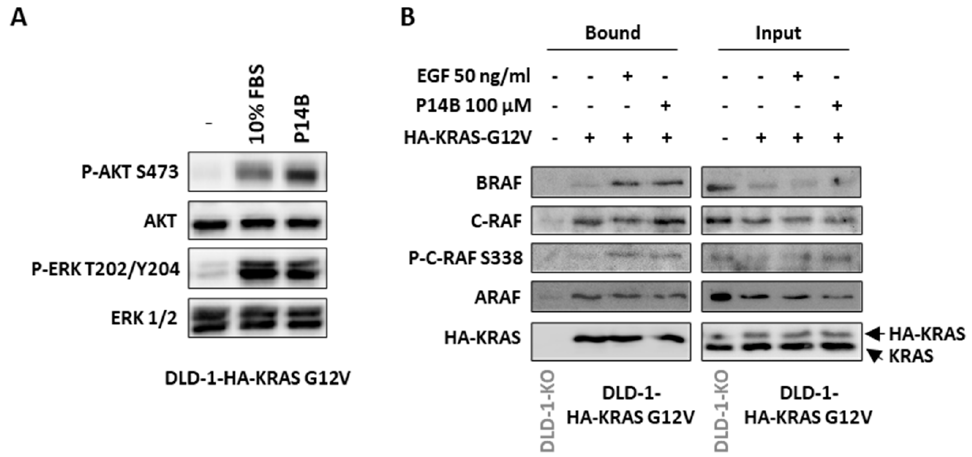
Figure 4. P14B treatment increases oncogenic KRAS interaction with its effectors BRAF and C-RAF/P-C-RAF. ( A ) Serum starved DLD-1 cells stably expressing HA-KRAS-G12V (DLD-1-HA-KRAS G12V) were incubated for 3 h with 100 µ M P14B, or for 30 min with 10% FBS. WB was performed with the indicated antibodies. ( B ) Co-immunoprecipitation of HA-KRAS G12V with BRAF, C-RAF/P-C-RAF, or ARAF was analyzed in starved DLD-1-KO cells stably expressing HA-KRAS G12V after being treated with P14B (100 µM) or EGF for 10 min. IP was performed with anti-HA antibodies and WB of the bound and input fractions with anti-BRAF, anti-C-RAF, anti-P-C-RAF(S338), and anti-ARAF-specific antibodies. (-) non-treated. 2.6. Viability of CRC Cells Expressing Oncogenic KRAS Is Impaired by Treatment with P14B, but Not That of Normal Cells